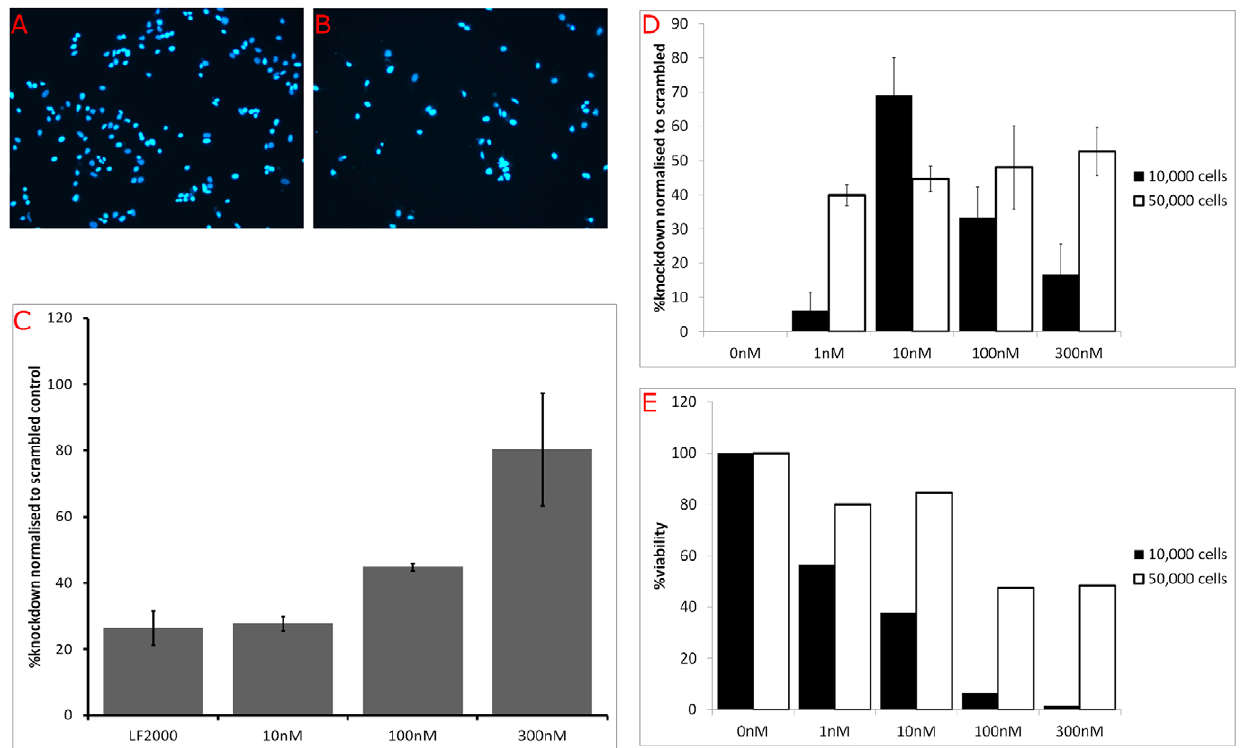
Figure 3. Knockdown of Actin from HeLa and Rat Aortic Smooth Muscle Cells. HeLa (A–C) or rat aortic smooth muscle cells (D, E) transfected with the either scrambled siRNA or siRNA against actin, as indicated, were seeded on six-well gelatine-coated plates 72 hrs post- transfection. Adherent, Hoechst–stained (nuclear) HeLa cells after transfection with scrambled siRNA (A) or actin siRNA (B) were counted by fluorescence microscopy, as described in the Methods section. Knockdown of actin in HeLa (C) or rat aortic smooth muscle cells (D) and its viability (E) was expressed as a percentage of the number of adherent cells transfected by actin siRNA over its scrambled control. Data represent the mean 6 SD of at least three independent experiments.